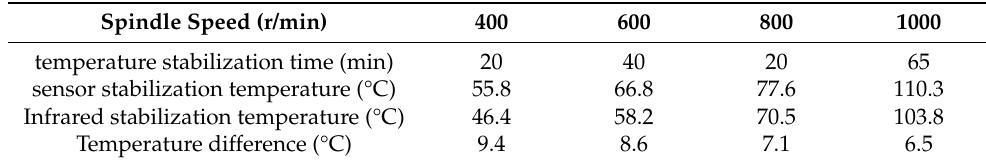
Table 5. Temperature contrast diagram of film thermocouple temperature sensor and infrared temperature